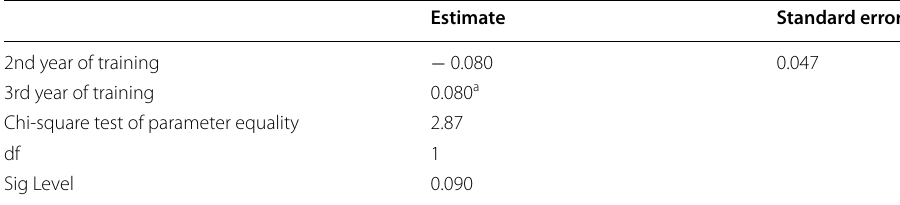
Table 16 Global DIF analysis to identify subgroup invariance between years of nursing education for measurement in the third